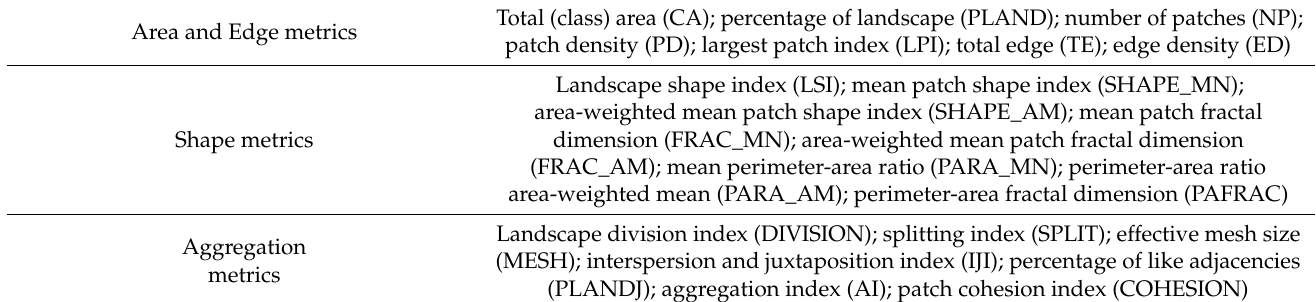
Table A2. Summary Table of Landscape Index.